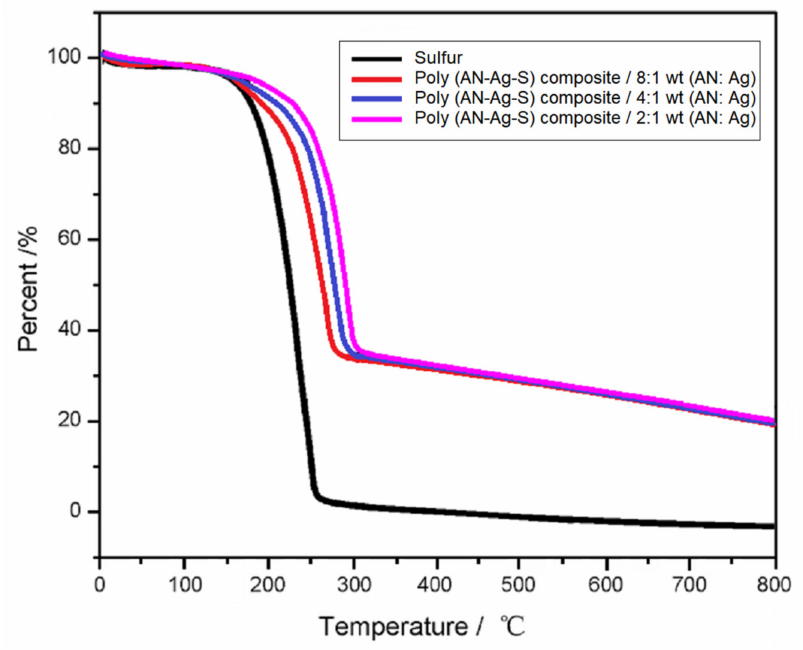
Figure 4. The TGA curves of poly (AN–Ag–S) composites with different Ag